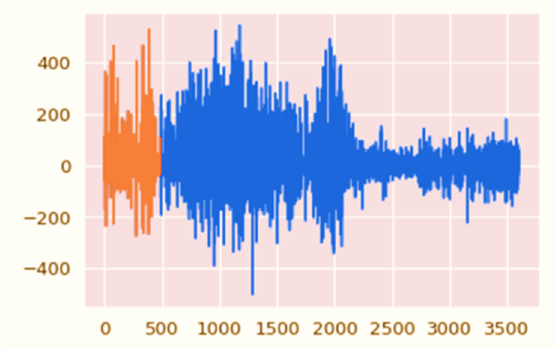
Figure 5. The orange part of the signal represents k minutes of the inter-ictal phase .